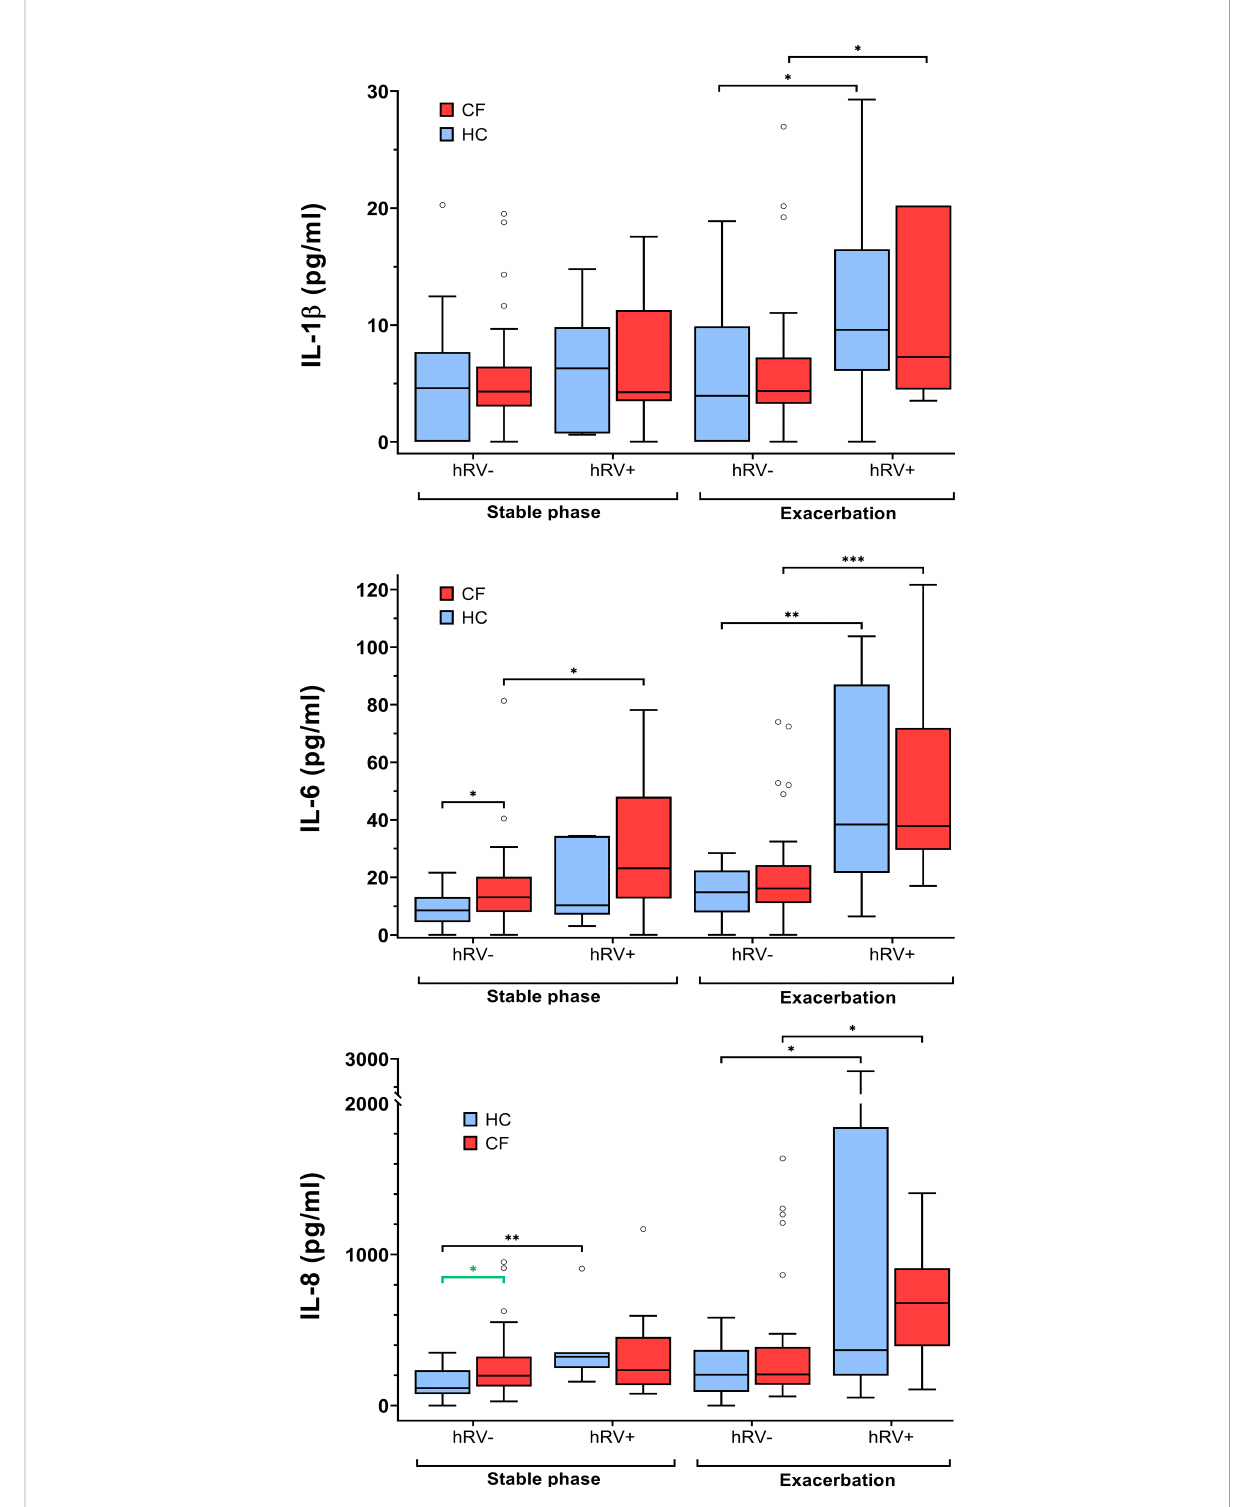
FIGURE 3 In fl ammatory markers in pwCF and HC with regard to hRV detection. Statistical signi fi cance levels are displayed as follows: *p <0.05, **p<0.01,